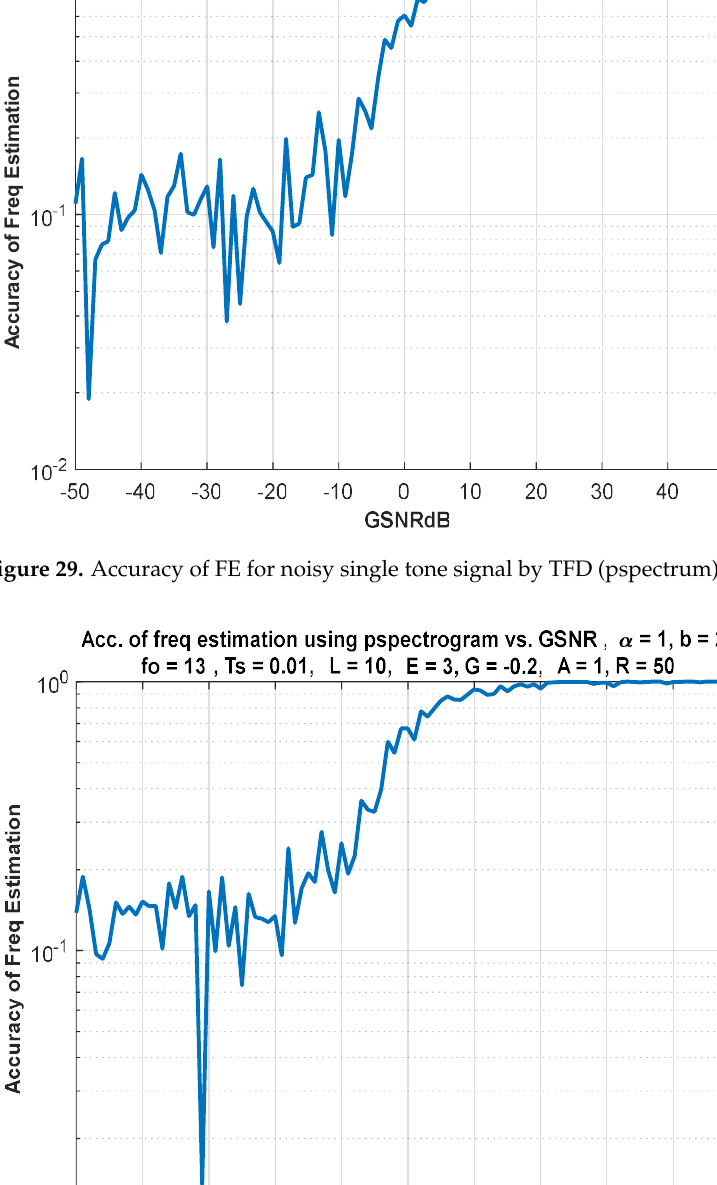
Figure 28. MSE versus GSNR for TFD of noisy LFM signal by pspectrum, where 𝛼 = 1 and 𝑏 = 20.